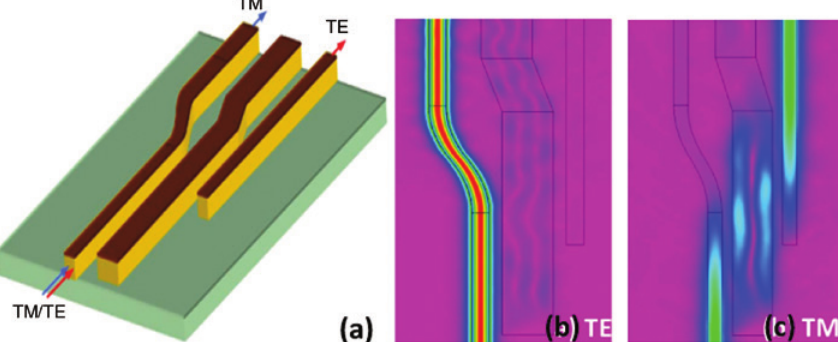
Figure 16: Proposed PBS assisted with higher-order modes. (A) Schematic configuration of a PBS with the TM (C) polarizations